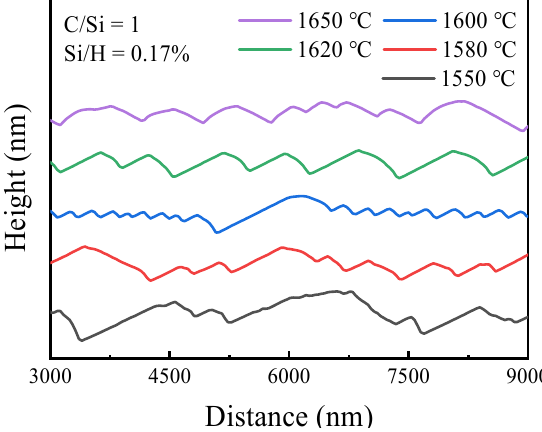
Figure 9. Line analysis of the 4H-SiC epitaxial wafers along the [112(–)0] direction.